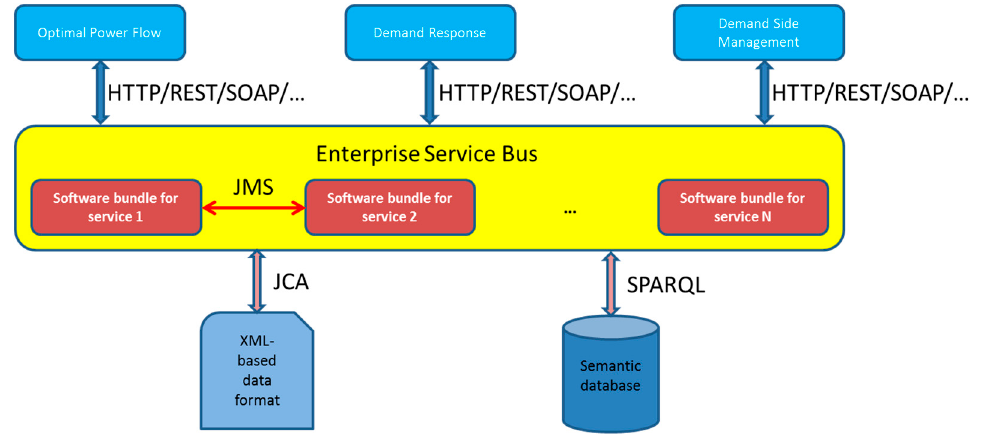
Figure 2. Enterprise Service Bus and interconnection capabilities.